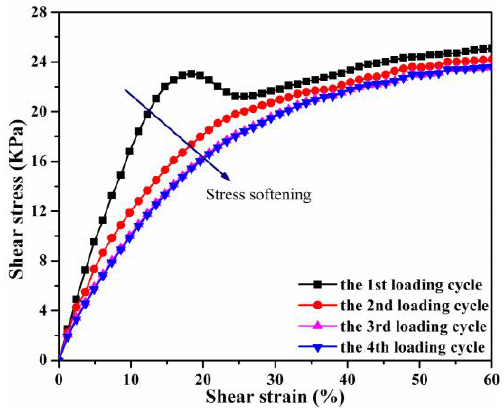
Figure 4. The steady-state shear stress–strain curves of MRE-0 under the repeated loading process in the zero-field condition.